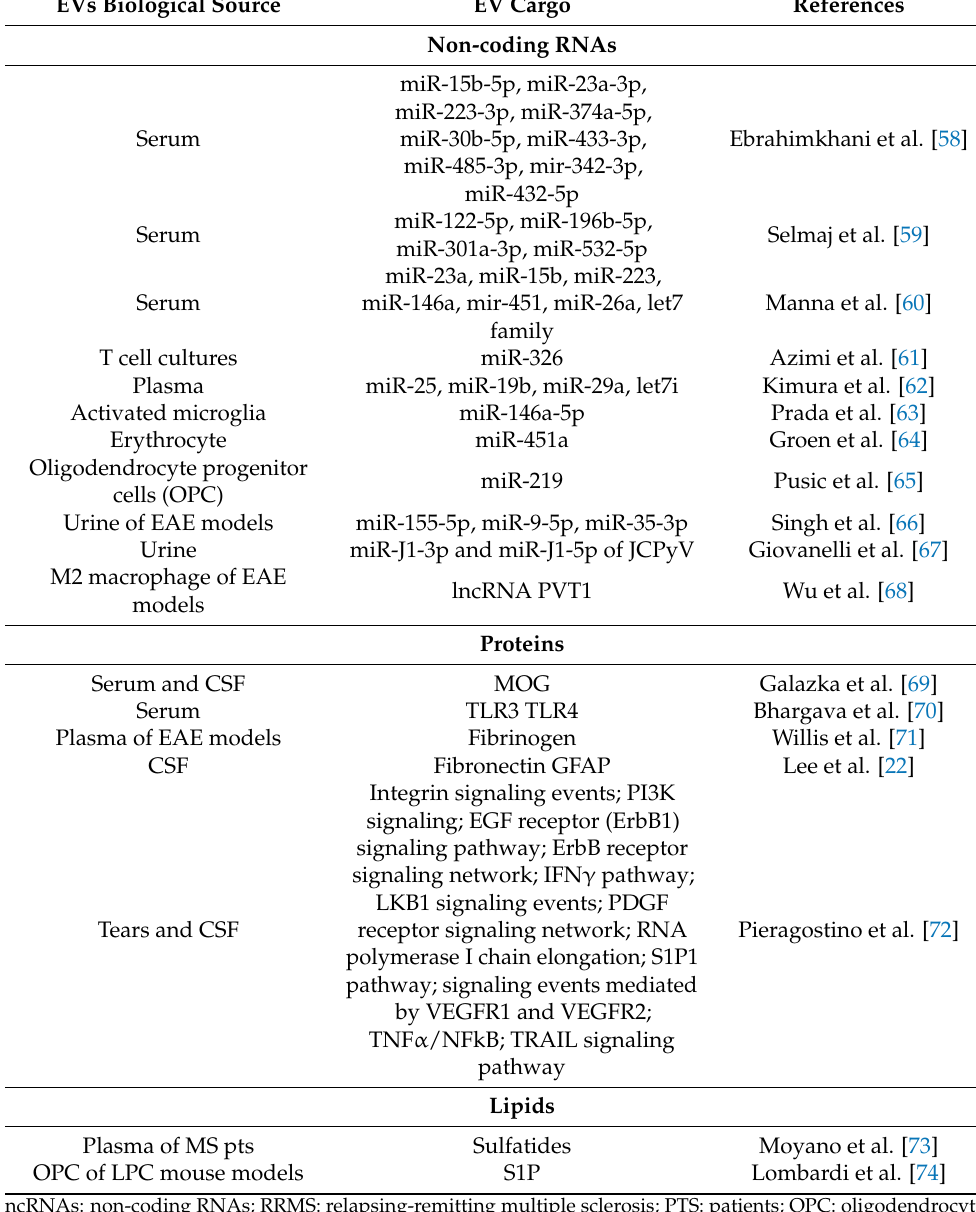
Table 1. Molecular EVs’ cargo detected in MS patients, and in in vivo and in vitro